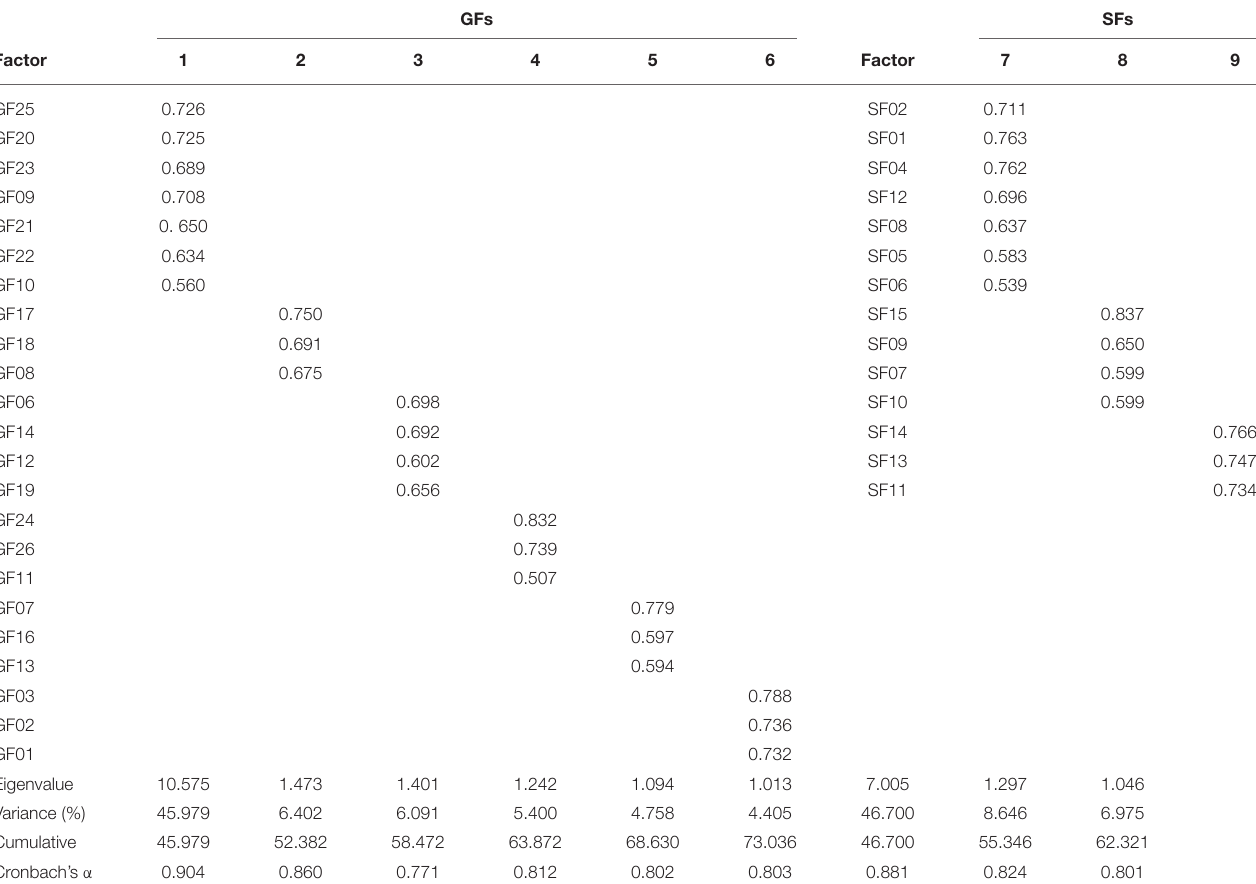
TABLE 6 | Rotated component matrix.